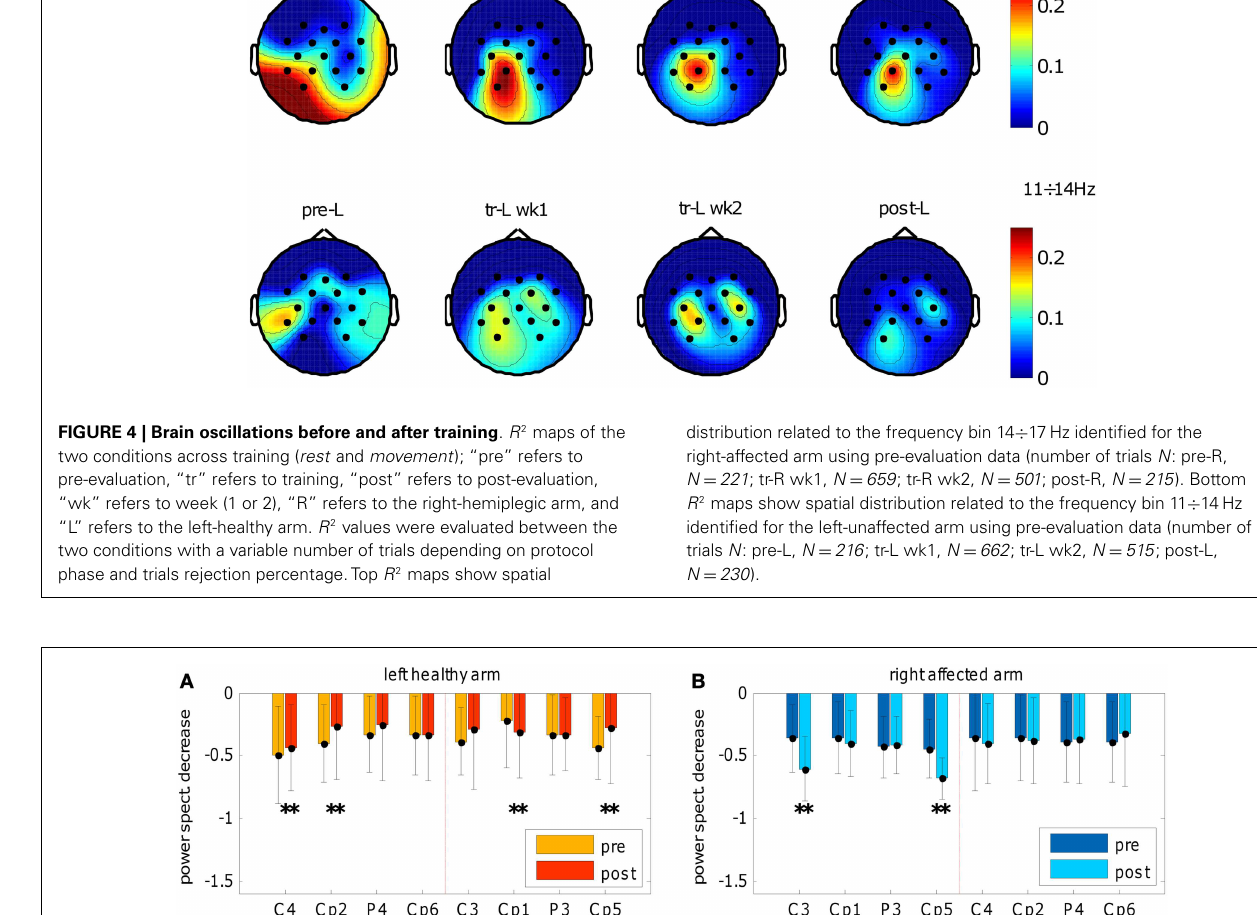
FIGURE 5 | Spectral power decrease . Comparison of spectral power decrease during movement execution between pre- and post-evaluations. (A) Frequency bin from 11 to 14Hz for left-healthy arm and (B) frequency bin from 14 to 17Hz for the right-affected arm.The graphs depict the movement-related de-synchronization as the fraction of spectral power decrease during a movement condition interval in comparison to the mean spectral power of the rest condition (of the same run); for each electrode mean and standard deviation was represented.The normalization to the mean